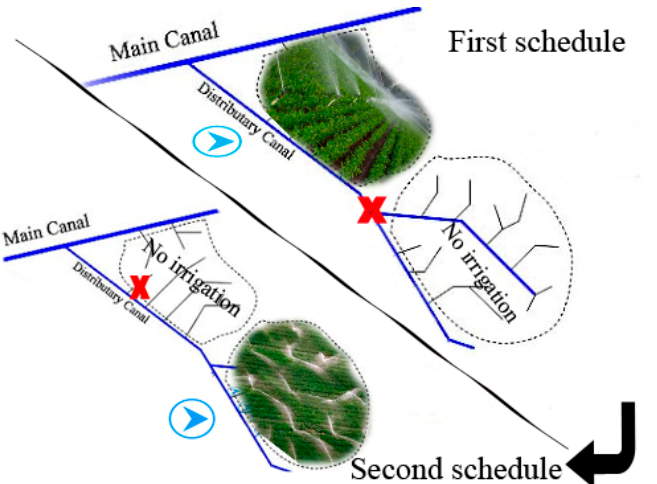
Figure 3. Schematic of water delivery scheduling (manual-based operating system A).